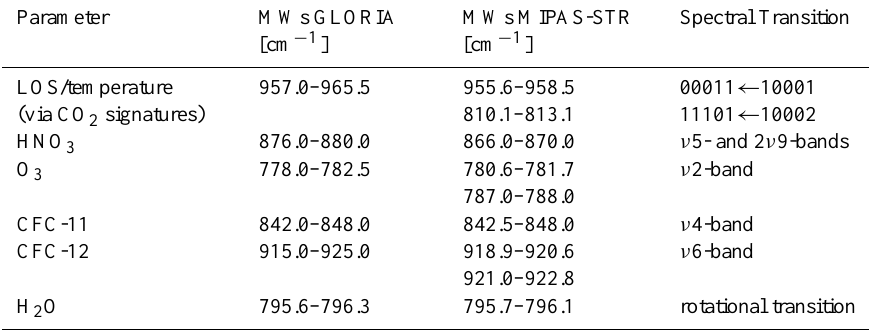
Table 2. Retrieval microwindows (MWs) used for GLORIA and